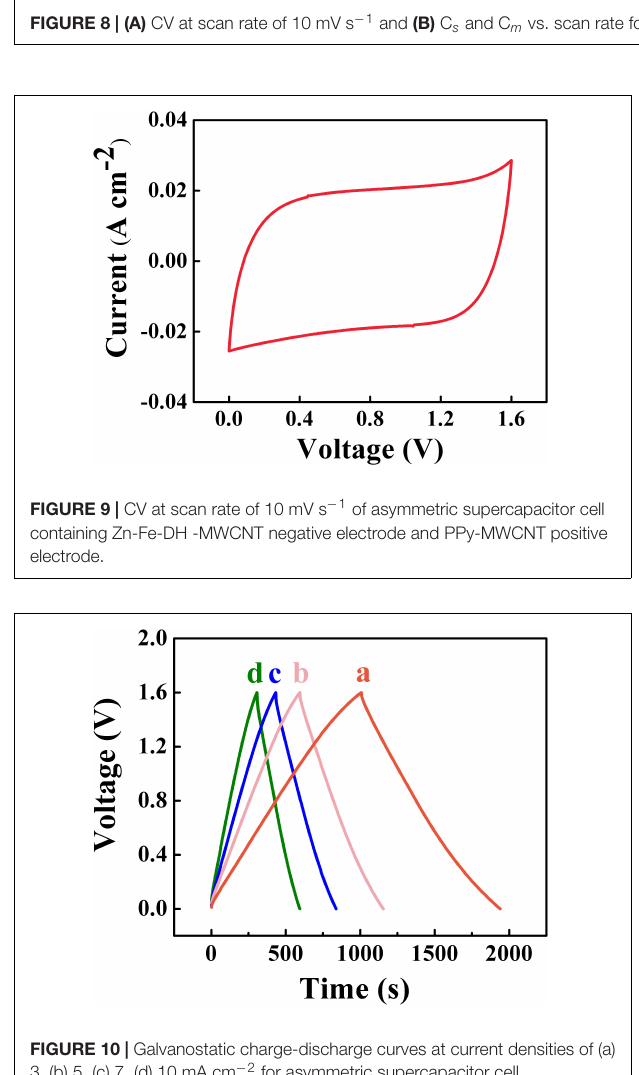
the electrodes was achieved at active mass loading of 40 mg cm − 2 , which is important for practical applications. It is important to note that low capacitance of negative electrodes is a